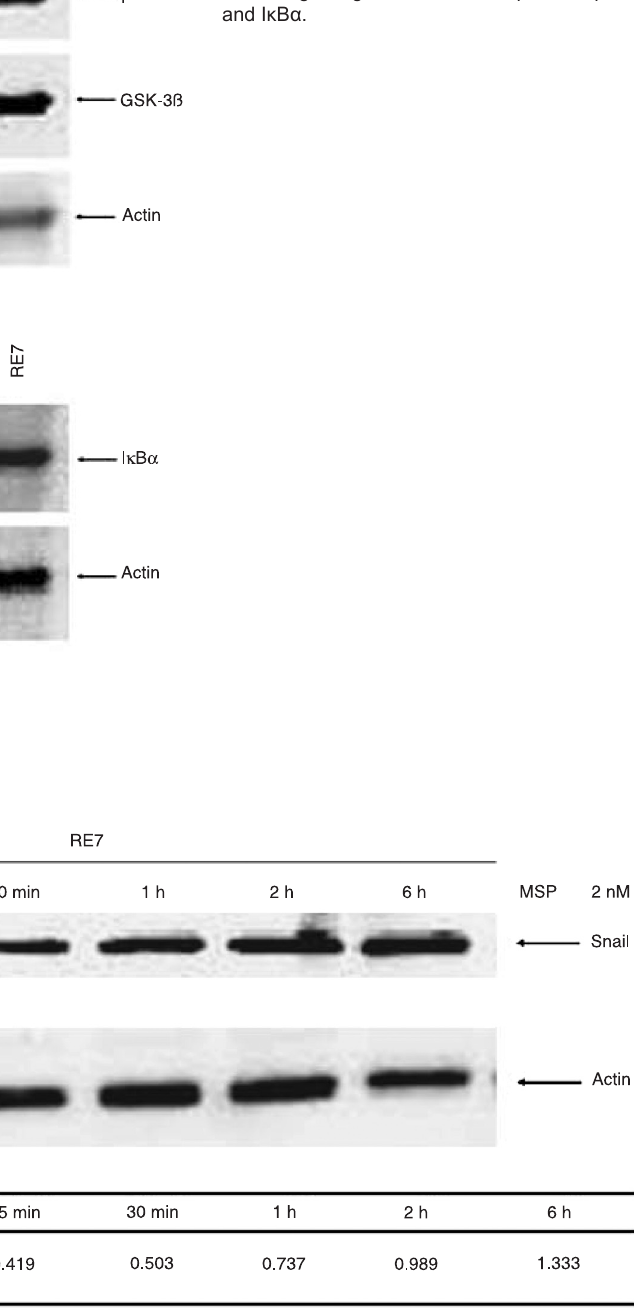
Figure 4. Changes of signaling molecules in macrophage stimulating protein (MSP)-stimulated RE7 cells. Cellular proteins from 2 nM MSP-stimulated MDCK and RE7 cells were probed in Western blots using 5 antibodies specific